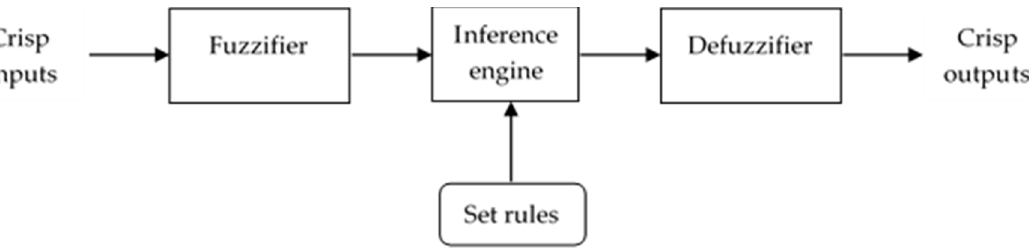
Figure 2. Fuzzy inference system architecture.